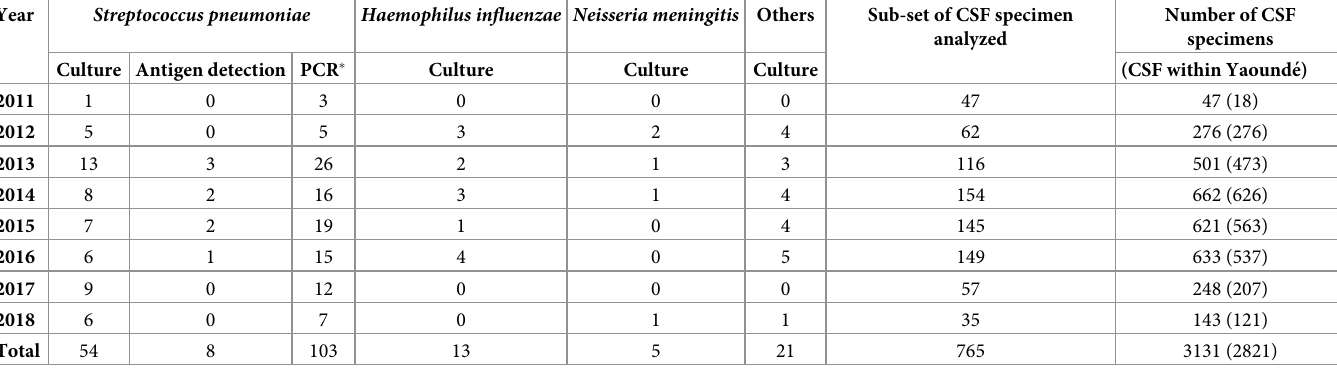
Table 4. Pathogens identified by culture (all pathogens) or other methods (pneumococcus only) from cerebrospinal fluid specimens of children aged 2–59 months from Cameroon. Year Streptococcus pneumoniae Haemophilus influenzae Neisseria meningitis Others Sub-set of CSF specimen